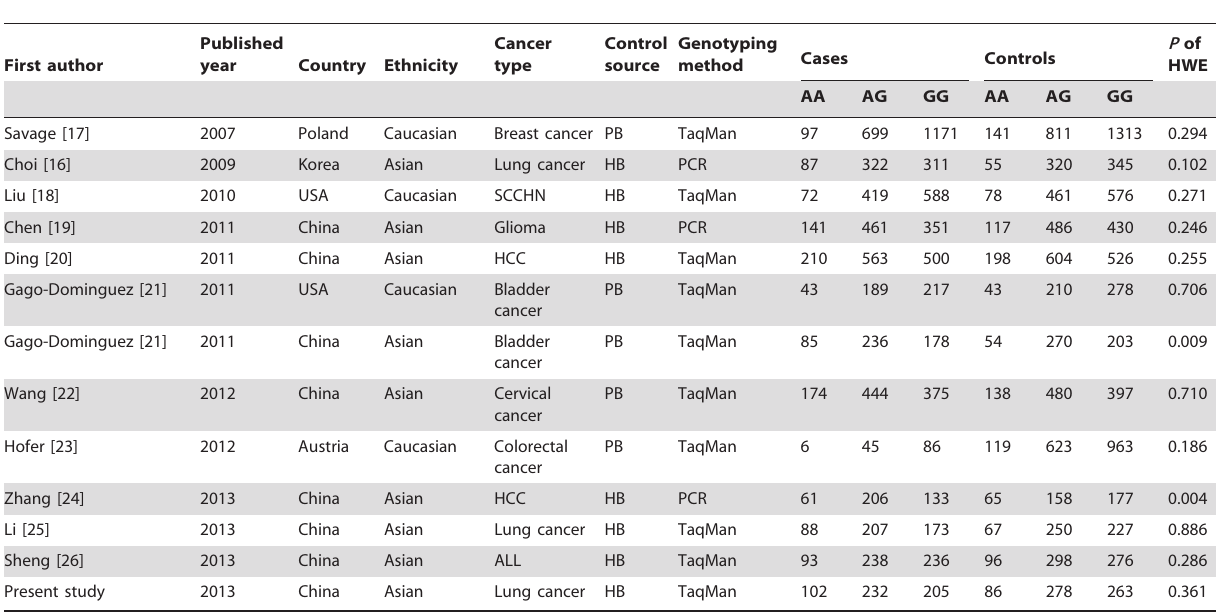
Table 3. Characteristics of the studies included in the